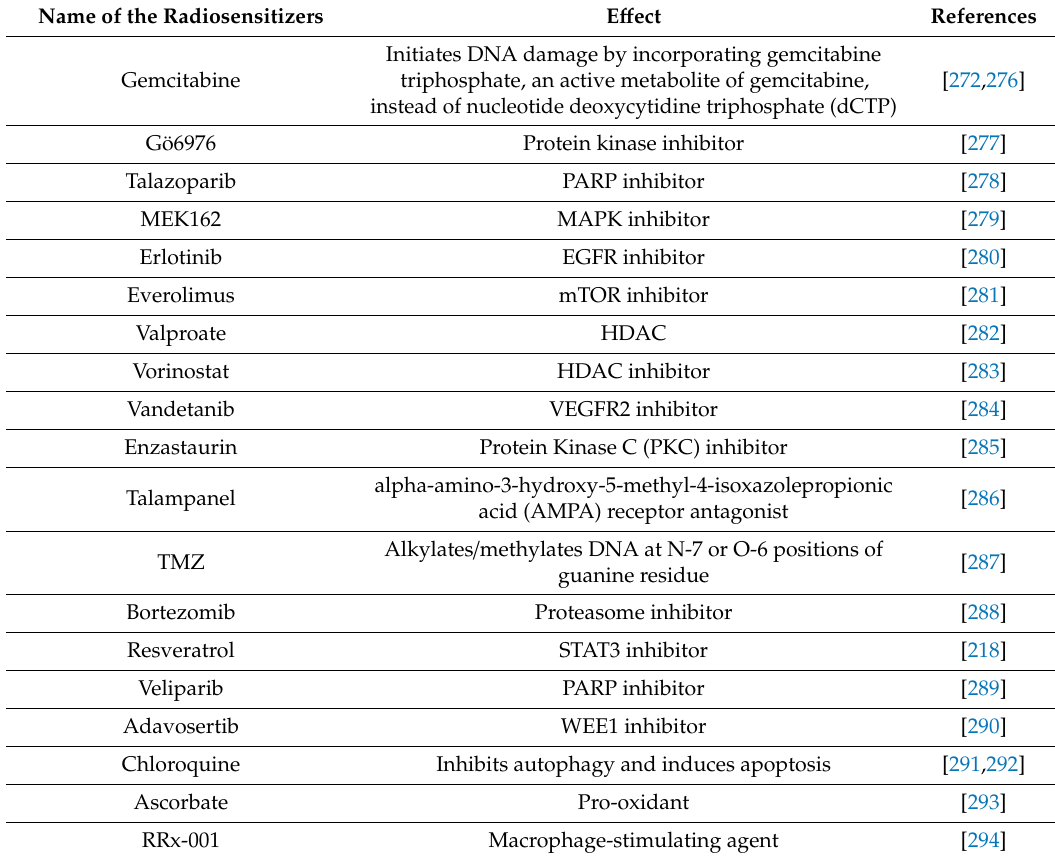
Table 1. List of drugs investigated as potential radiosensitizers for GBM treatment. Name of the